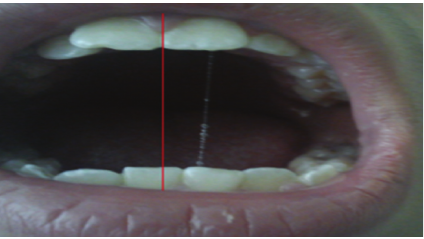
Figure 12: Trismus measurement for a picture concerning a half mouth opening. The distance of the mouth opening is 4.1716cm.